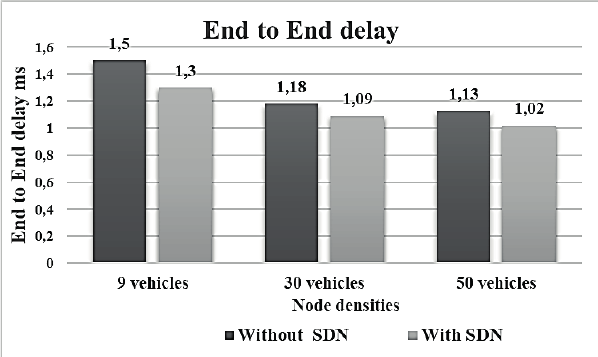
Fig. 11. End-to-end delay results (ms).